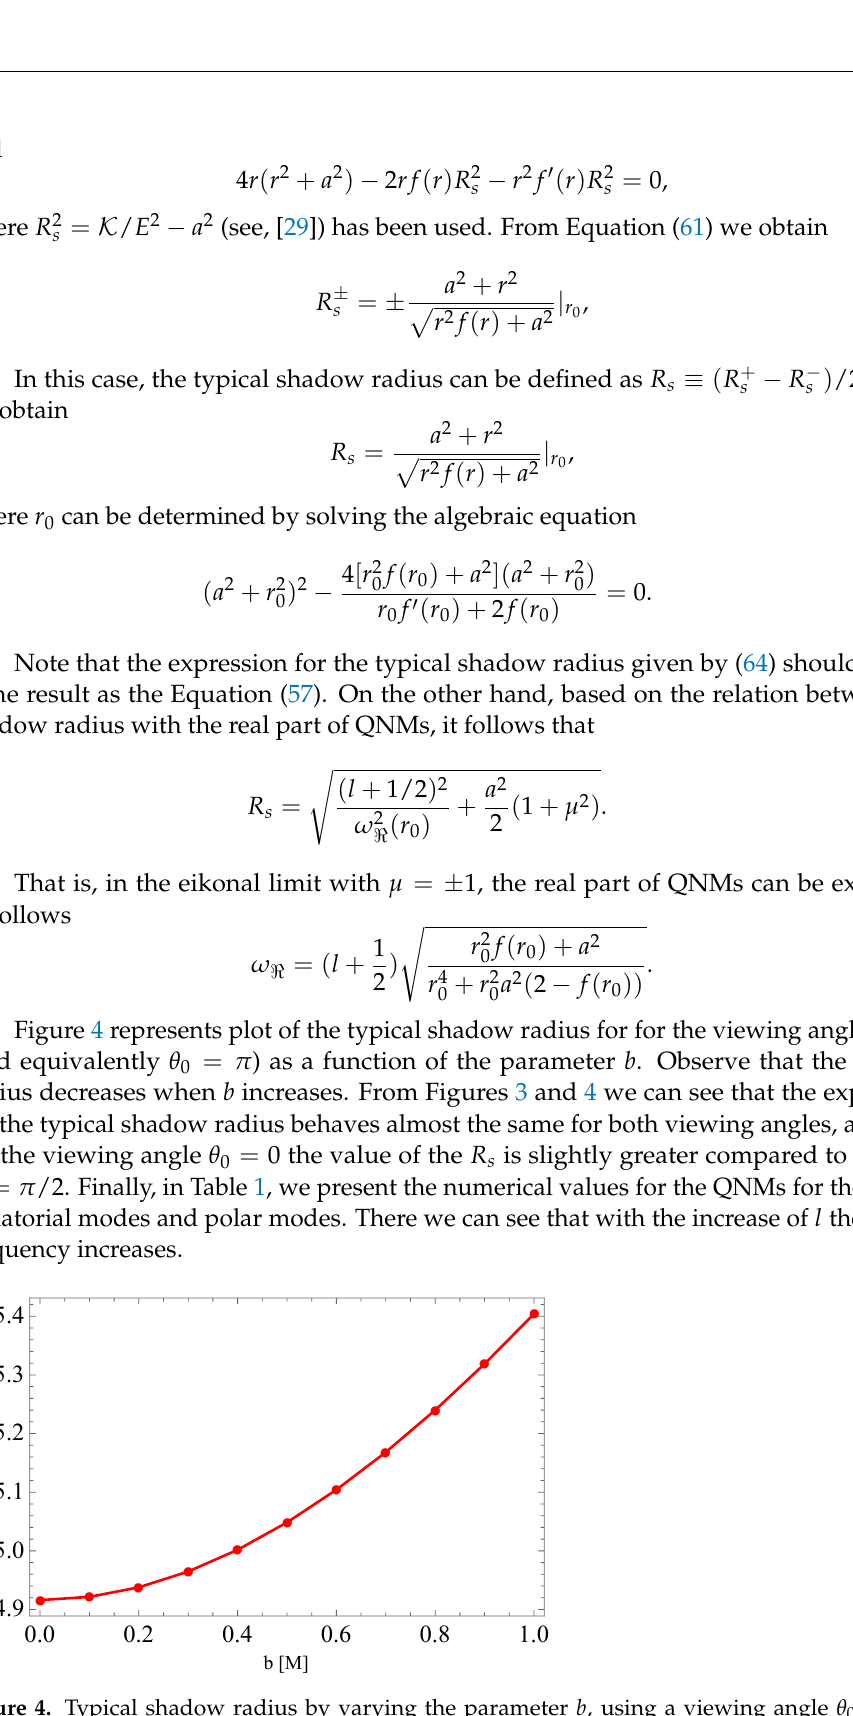
Figure 4. Typical shadow radius by varying the parameter b , using a viewing angle θ 0 = 0 (or equivalently θ 0 = π ). We have used a =